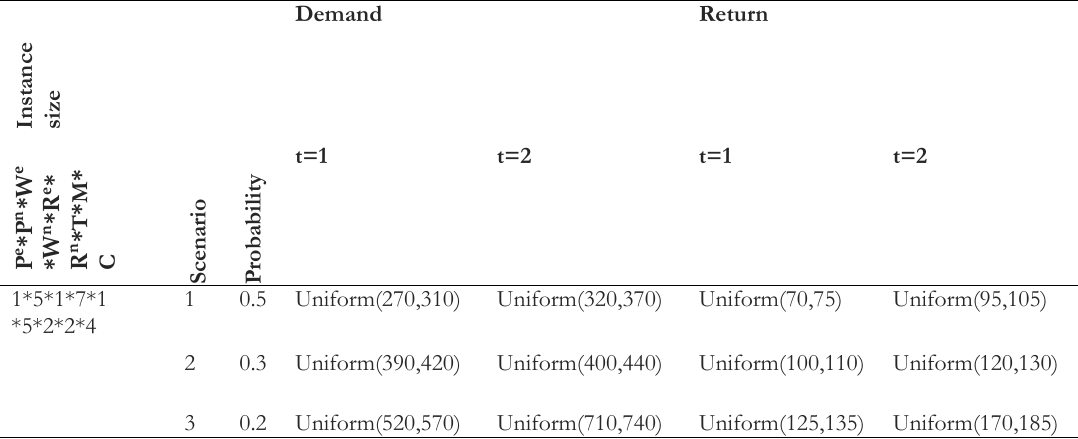
Table 5. Problem characteristics in the small test